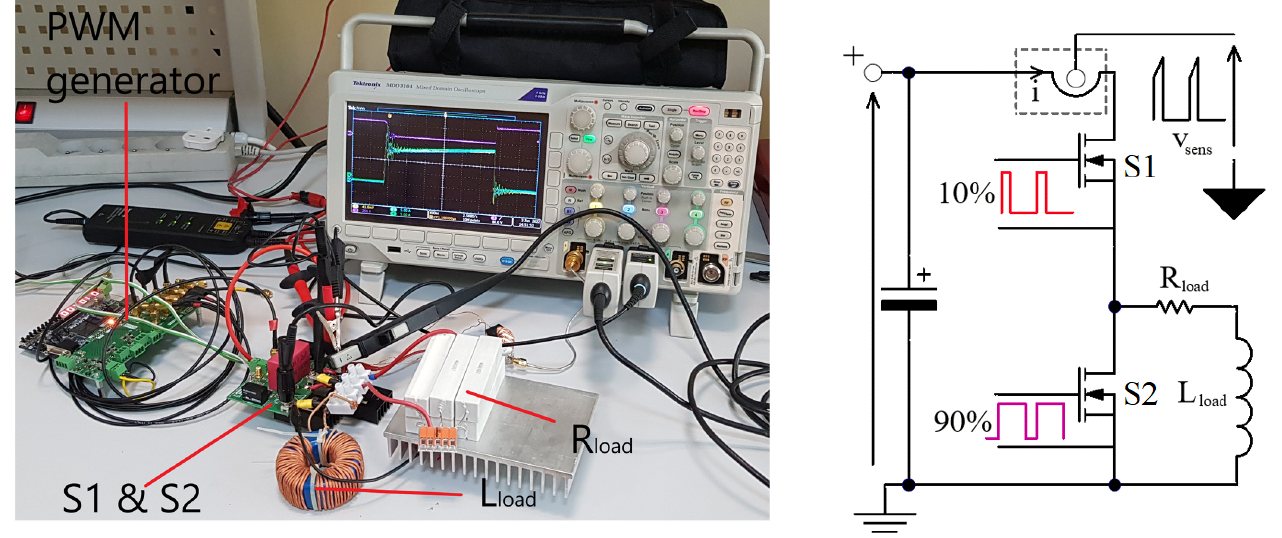
Figure 9. The laboratory setup for the pulse generation with a rapid current